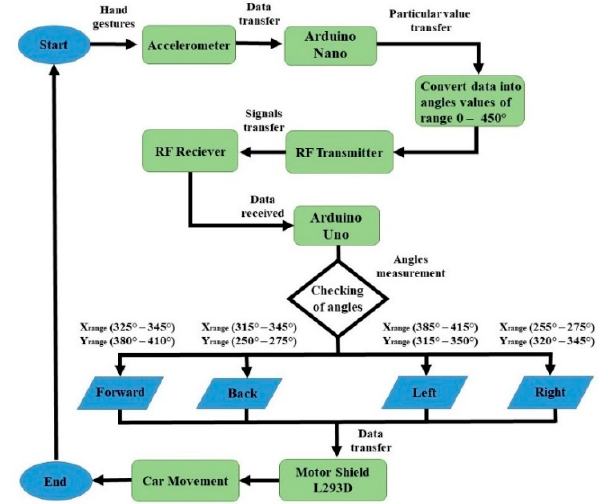
Figure 4. The flow diagram of the hand-gesture based car controlling.